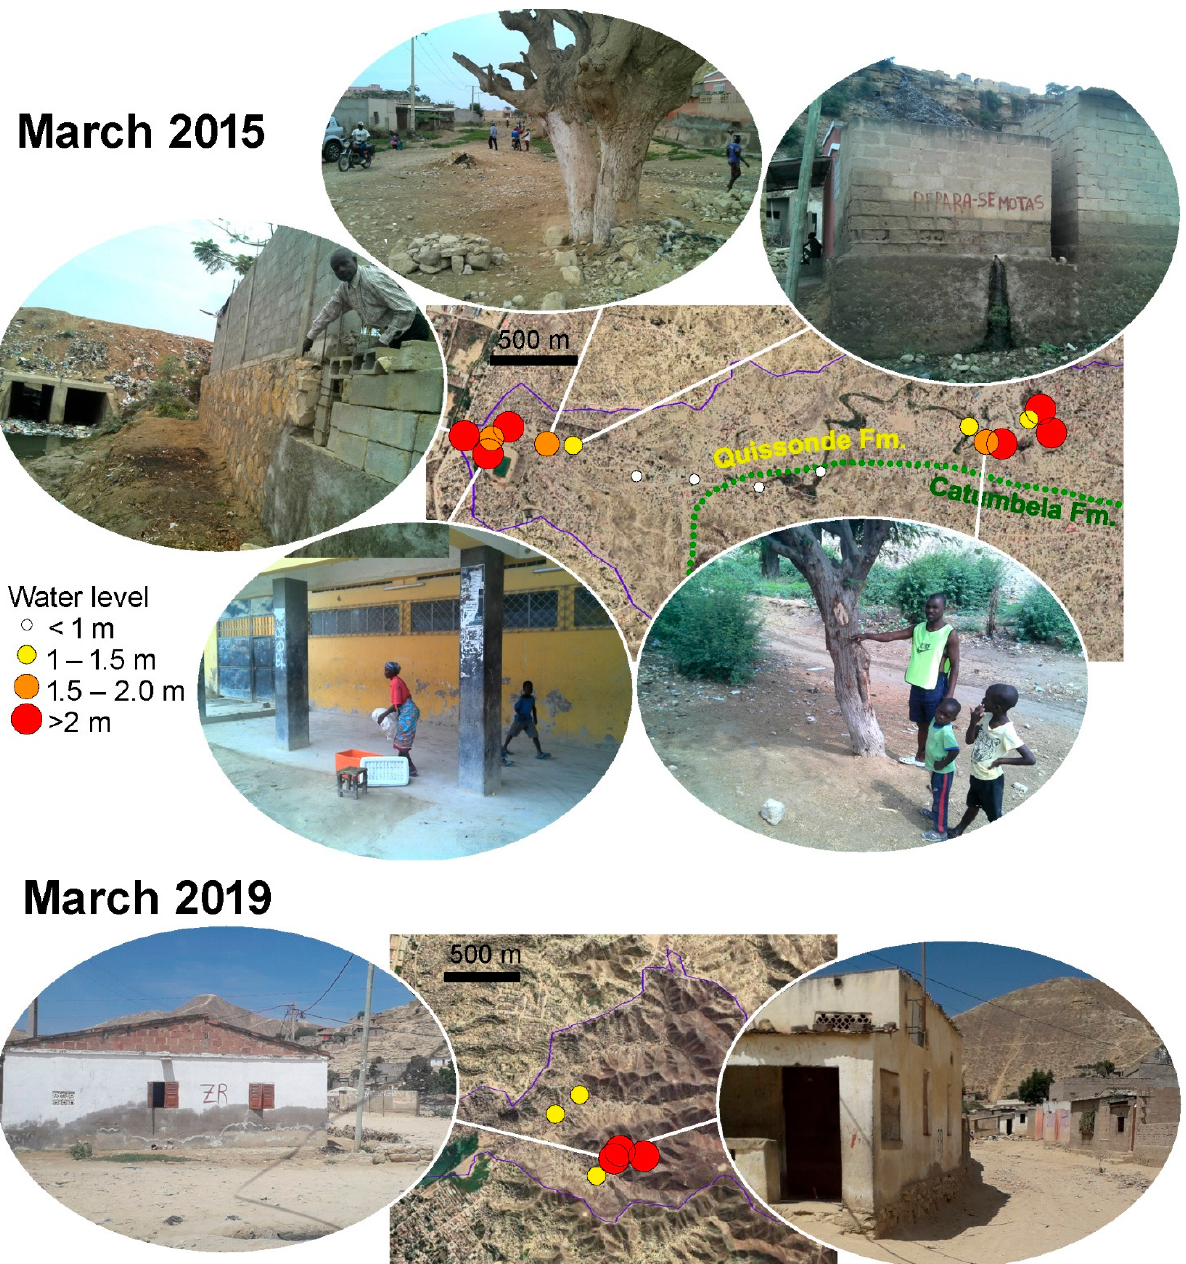
Figure 6. Water levels reached in the drainage areas most affected by the flash floods of 2015, in the outskirts of Lobito, and 2019, in Catumbela. The catchment most affected by the 2019’s event is entirely in Quissonde Formation.